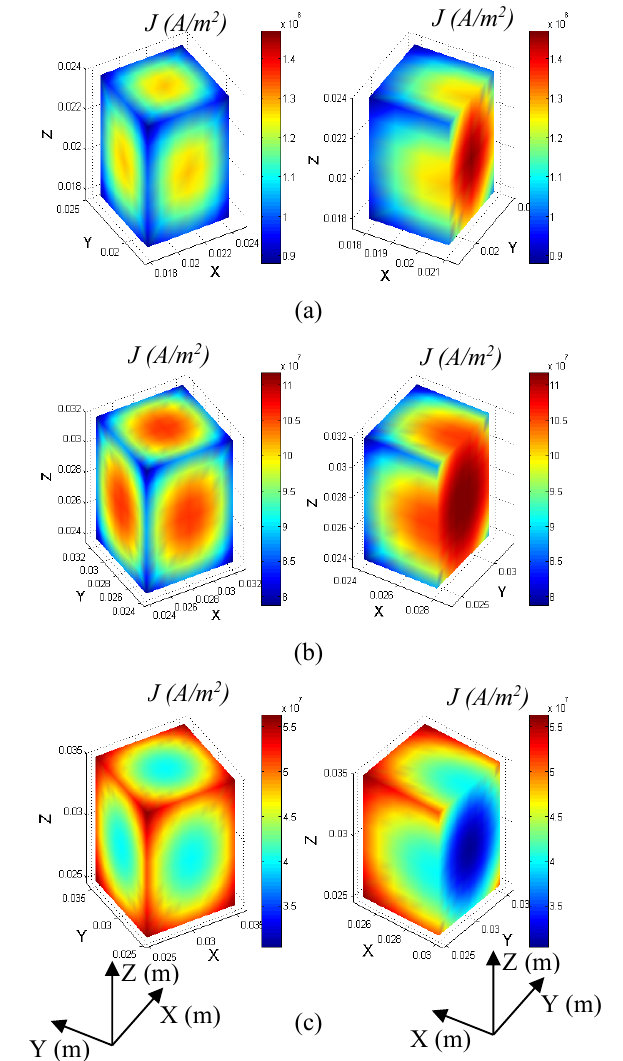
Figures 5 : Current density distribution of the J at t=0.06 S